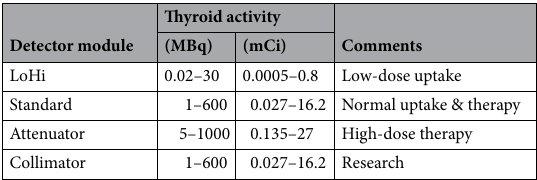
Table 1. The different detectors and their